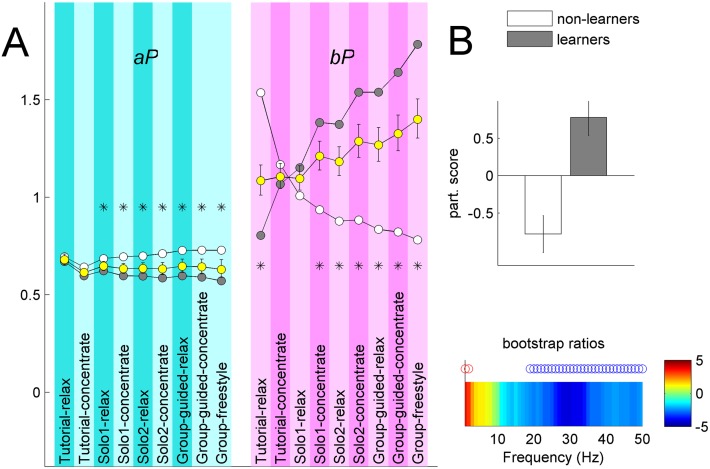
Neurofeedback performance measures.
(A) Group mean alpha performance aP and beta performance bP for all participants taken together (yellow bullets), with 95% CI’s shown as error bars, beta learners (gray bullets) and non-learners (white bullets). Conditions where neurofeedback did not depend on the respective band of interest are shown in desaturated color. Black asterisks indicate conditions which expressed reliable PLS difference between learners and non-learners. (B) Analysis of differences in baseline RSP between beta learners and non-learners. Top: mean participant scores with error bars representing 95% CI. Bottom: associated frequency pattern for the left frontal channel with reliable positive (negative) bootstrap ratios indicated by red (blue) circles. High power in delta range and low power in beta/gamma range during baseline predicted subsequent beta learning.